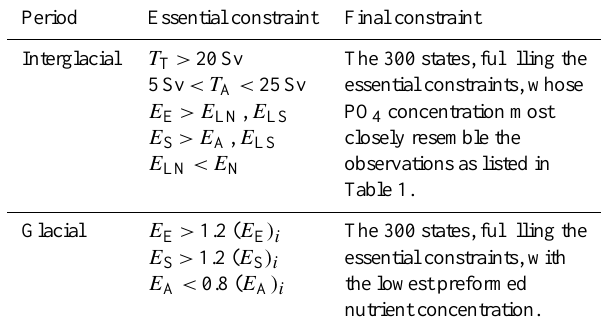
Table 2. Constraints used to derive the 300 interglacial and glacial. E Z denotes the export flux from box Z and is equal to P Z · α z · V Z